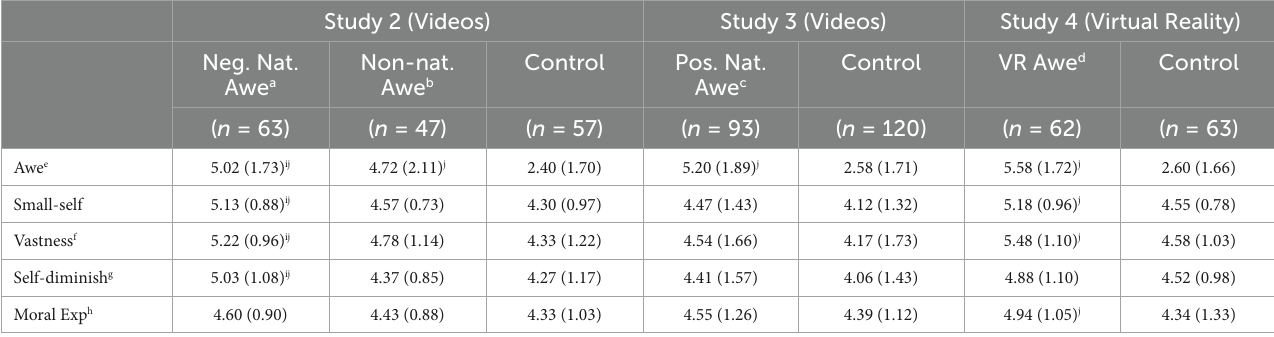
TABLE 2 Mean and standard deviation scores for self-reported awe, small-self, and moral expansiveness in Studies 2, 3, and 4.